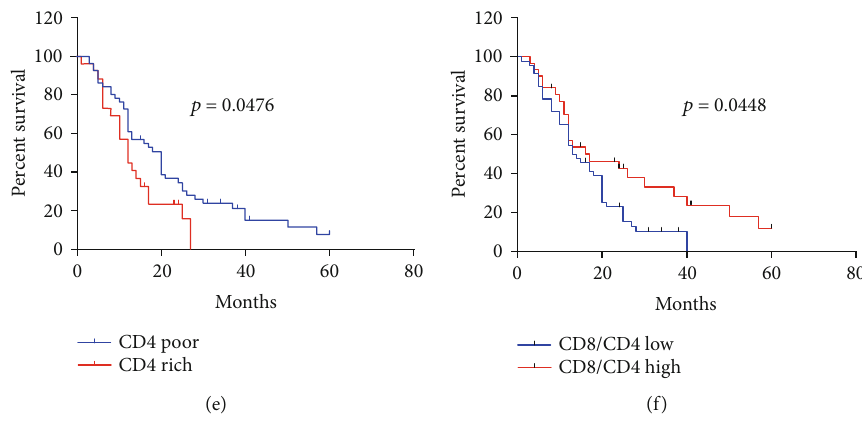
Figure 3: CD4 + TILs colocalize with PD-L1 + cells and contribute to poor survival. (a) Representative multi-IF images showing a sample with more CD4 + TILs than CD8 + TILs in the stroma. Scale bar, 100 μ m. (b) Representative multi-IF images showing a sample with more CD8 + TILs than CD4 + TILs in the stroma. Scale bar, 100 μ m. (c) A pie chart was plotted according to IHC staining results showing 84% of patients have more CD4 + TILs than CD8 + TILs in the stroma. (d) Representative multi-IF images showing a sample with PD-L1 + cells colocalizing more with CD4 + TILs than with CD8 + TILs in the stroma. Scale bar, 100 μ m. (e) The Kaplan – Meier survival analysis showing patients with elevated levels of CD4 + TILs (red line, n = 26 ) have poor OS, compared to patients with low levels of CD4 + TILs (blue line, n = 51 ). (f) The Kaplan – Meier survival analysis showing patients with a low CD8/CD4 ratio (blue line, n = 46 ) have poor OS, compared to patients with a high CD8/CD4 ratio (red line, n = 31